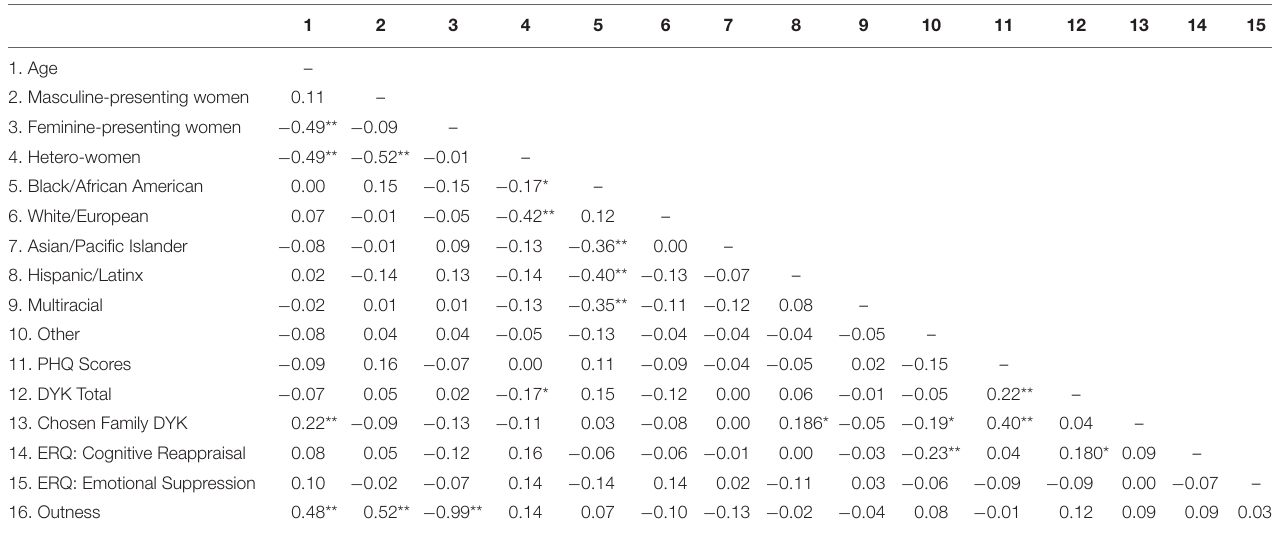
TABLE 2 | Zero-order correlations among study